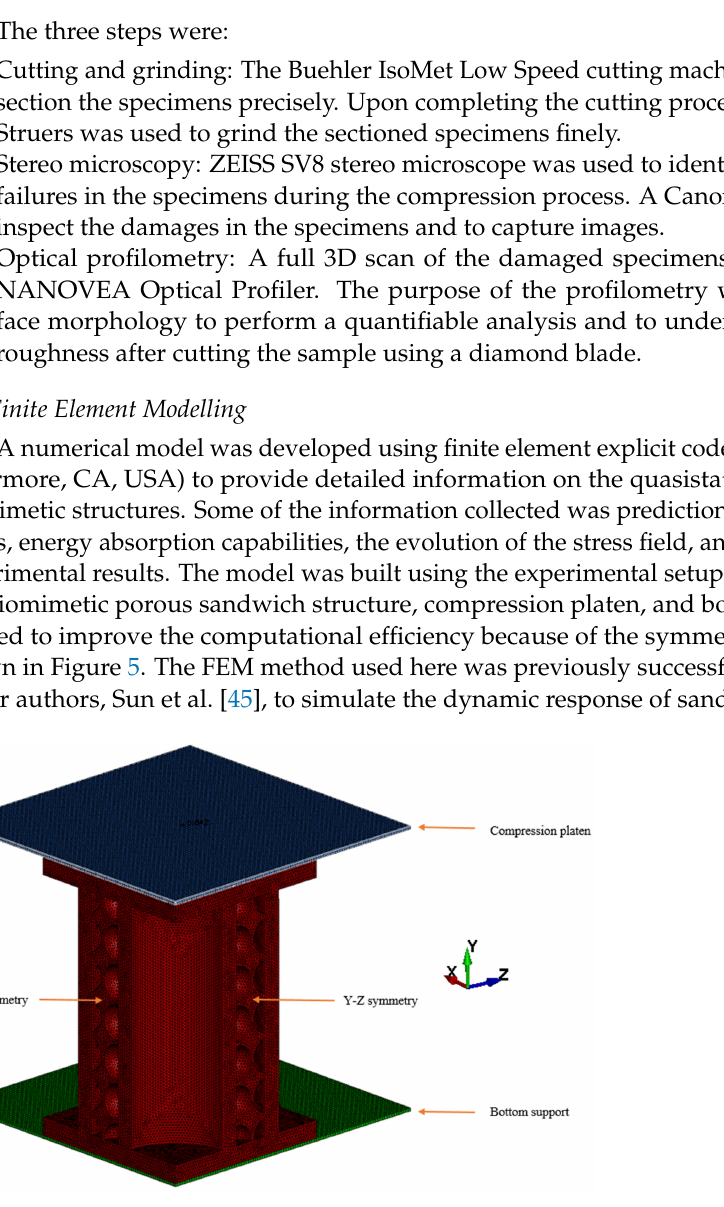
Figure 5. A quarter finite element of the compression plates and biomimetic porous sandwich struc- ture. sandwich Since the sandwich structure incorporating various shapes and geometries would undergo deformation during the compression process, a small mesh size of 0.25 mm dis- cretised the part. The adopted mesh size was verified to be adequate for producing con- verged results by a mesh sensitivity analysis. Solid elements were used to model the bio- mimetic structural part. The part was meshed using tetrahedral solid elements with 1 point tetrahedron (ELFORM = 10) to overcome negative volumes in large deformation and distortion situa- tions. The degree of freedom (DOF) of the bottom support was all constrained to simulate the fixed boundary condition, and the symmetry boundary conditions were imposed on the symmetry of the sandwich structures. Using the example of the X-Y symmetry plane (from Figure 5), the symmetric conditions on that plane in FE model were applied as fol- lows according to the LS-DYNA guidelines: Boundary set conditions: •